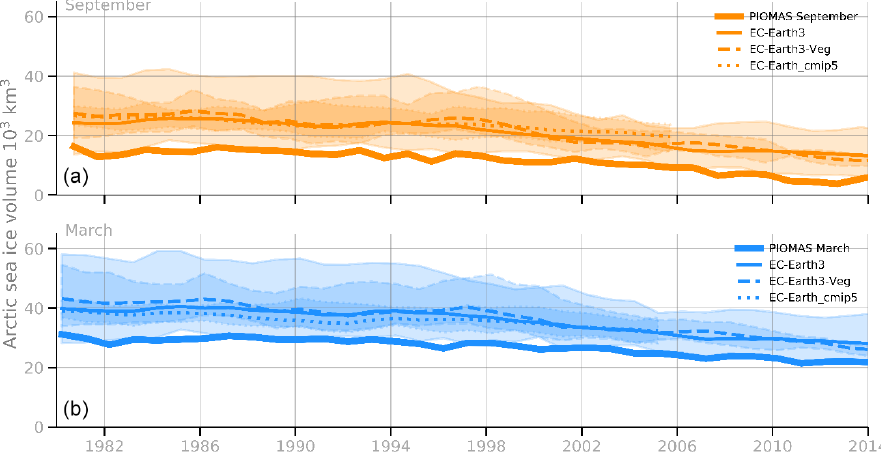
Figure 12. Time series of September (orange, upper panel) and March (blue, lower panel) Arctic sea ice volume for EC-Earth3 (thin solid lines representing the ensemble mean), EC-Earth3-Veg (dashed lines representing the ensemble mean), the CMIP5 version of EC- Earth (dotted lines), and PIOMAS reanalysis (thick solid lines). The EC-Earth3 and EC-Earth3-Veg ensemble minimum and maximum are represented by the same line style as their means, but with transparent shading added around the ensemble